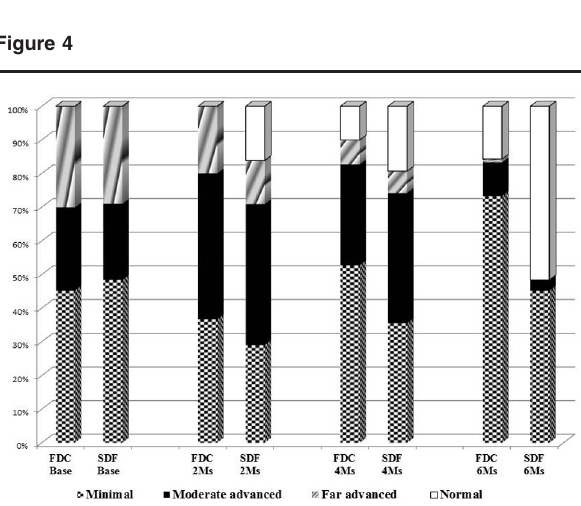
Graphic presentation of radiological response of PTB with FDC compared to